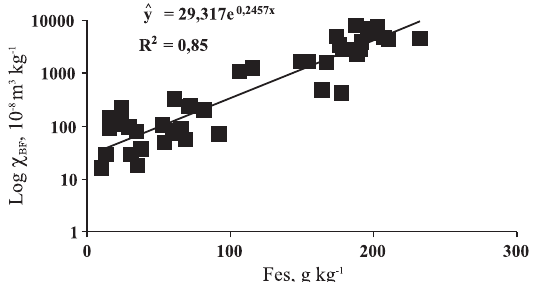
Figura 3. Valores de χχχχχ em relação ao teor de ferro BF no extrato sulfúrico (Fes) das amostras analisadas.